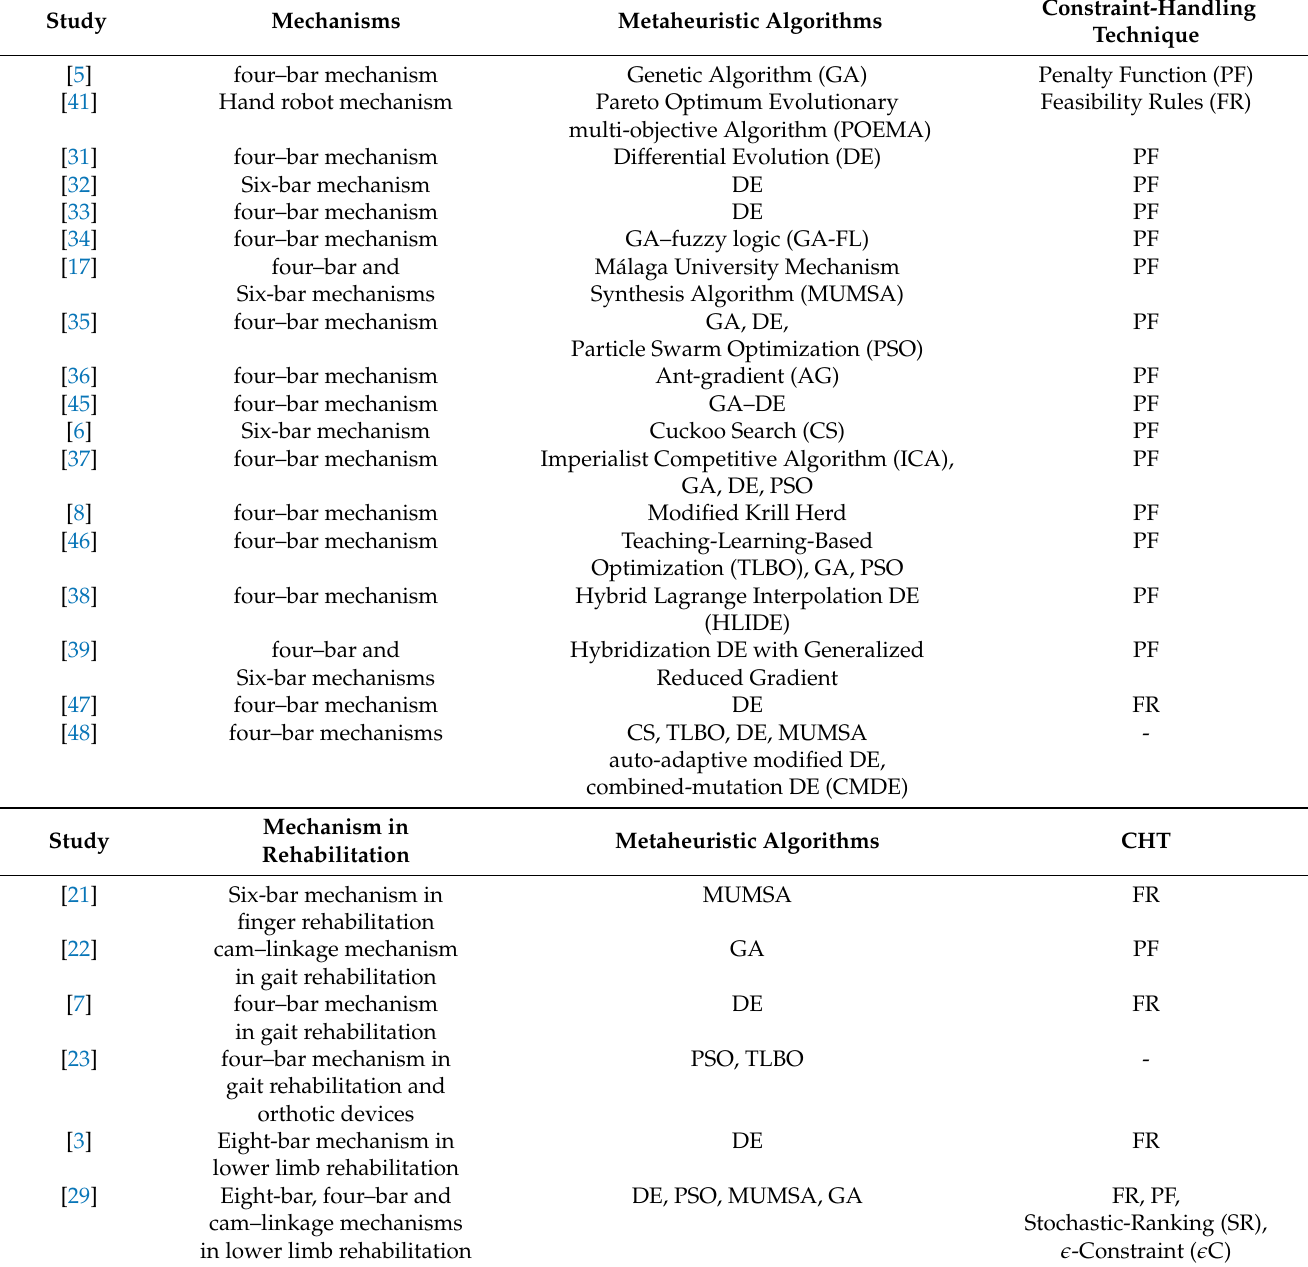
Table 1. Summary of investigations using metaheuristic algorithms and constraint-handling tech- niques in mechanism synthesis problems in a broad context and for specific rehabilitation